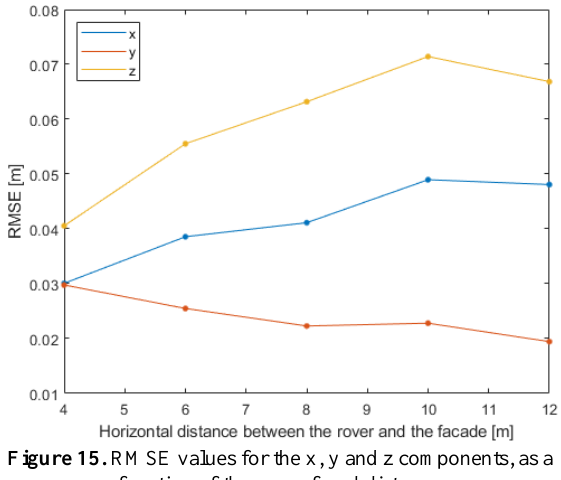
Figure 15. RMSE values for the x, y and z components, as a function of the rover-faced